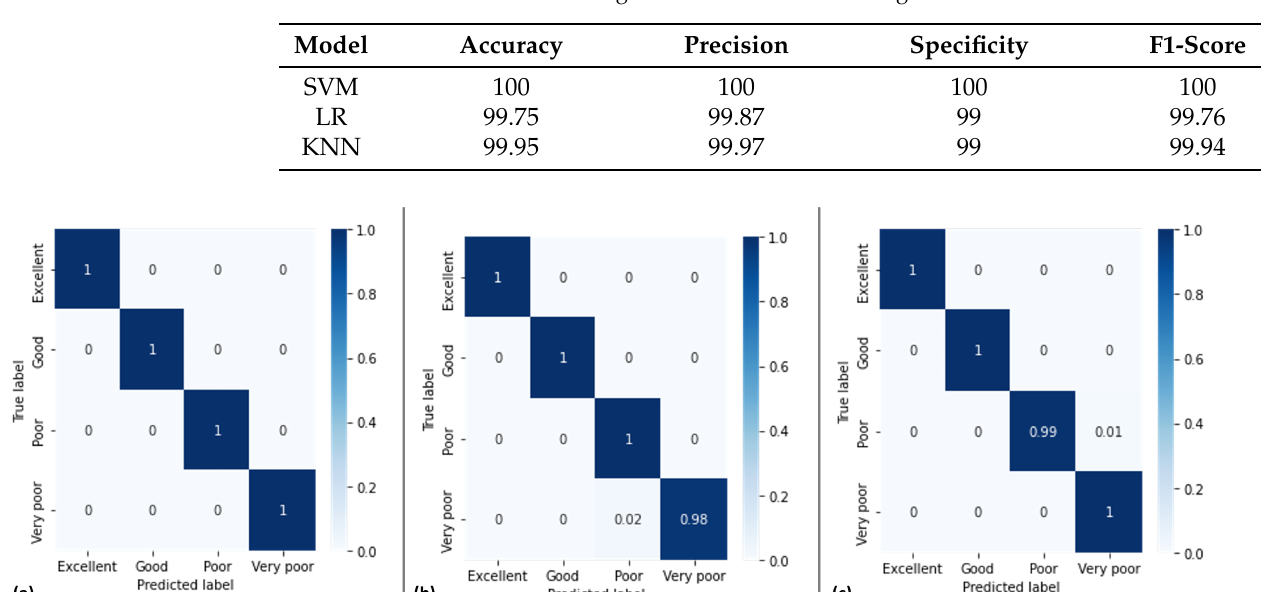
Table 8. Classification results using the water zones embedding.